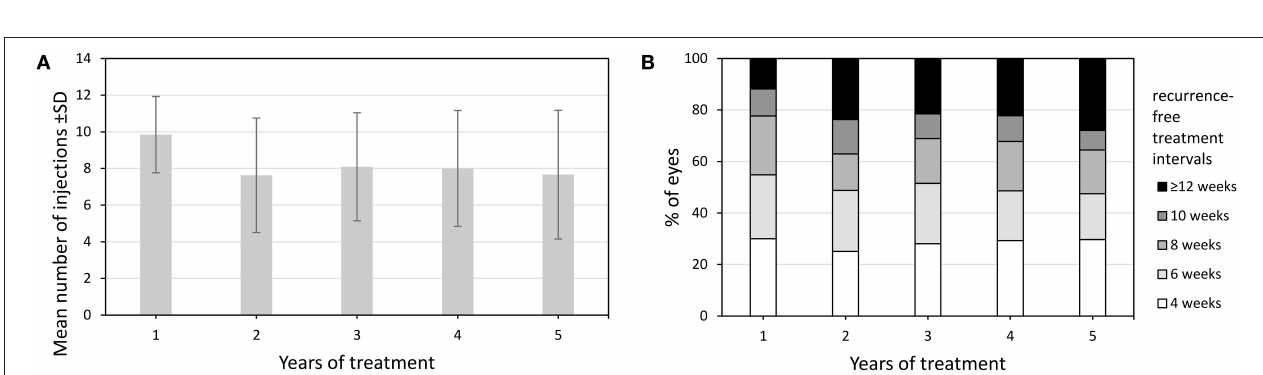
FIGURE 3 | Best-corrected visual acuity (BCVA) change of all eyes (treat-and-extend regimen & exit) from baseline until year 6. Values are shown in Early Treatment of Diabetic Retinopathy Study (ETDRS) letters ± SD, standard deviation.